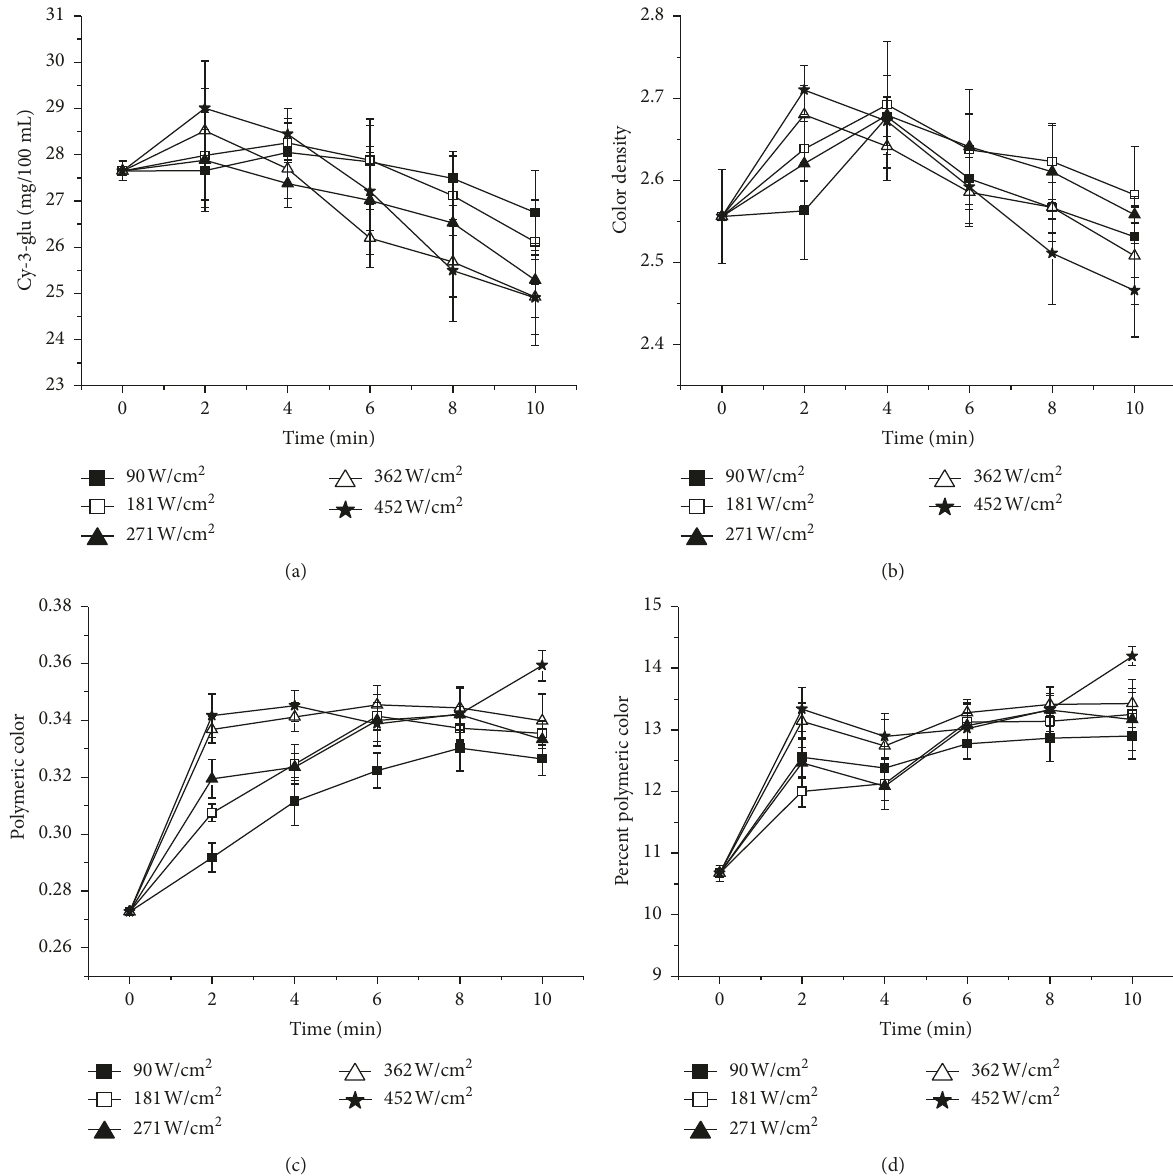
Figure 3: Effects of ultrasound processing on monomeric anthocyanins and polymeric color of bayberry